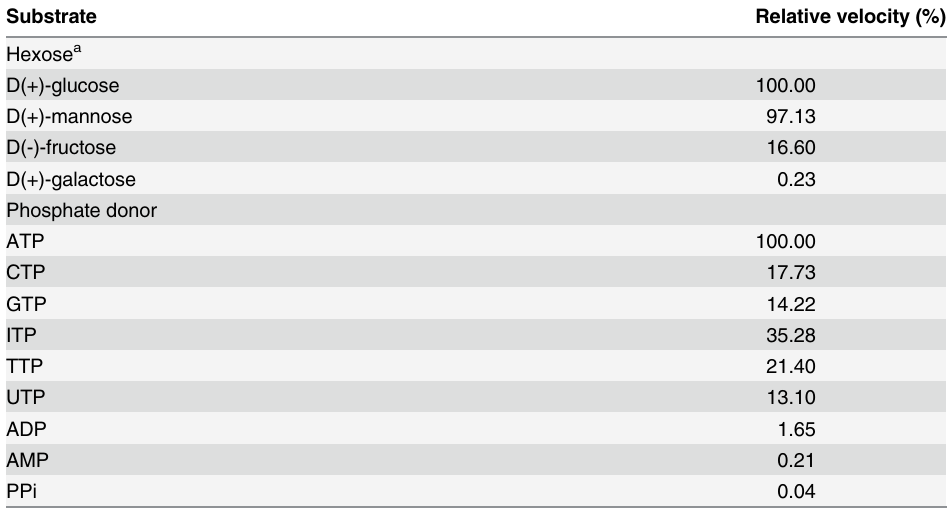
Table 1. Substrate speci fi city of r Cs HK.